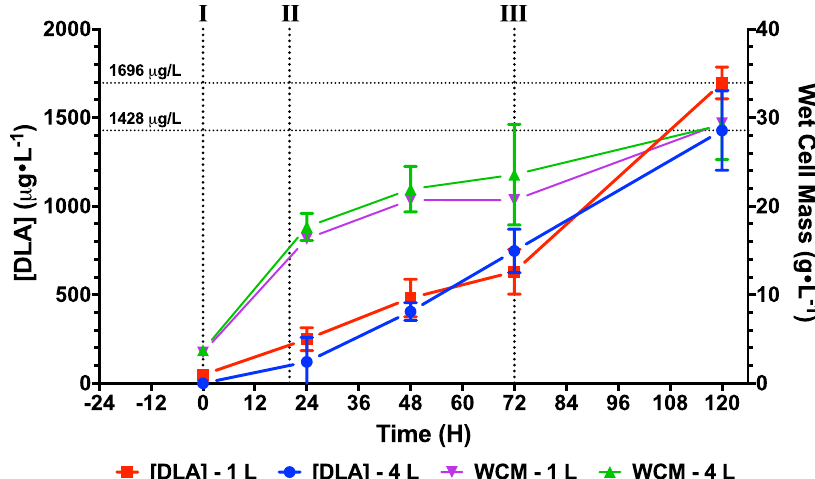
Fig. 6 Production of DLA from DLAM33B in 1 and 4 L scale fermentation. The fermentation process was modeled after the induction protocol used in shake fl ask experiments, with additional galactose and 10X SC-URA media supplemented at de fi ned feeding phases (I, II, III) in a fed-batch mode. 50 mM Ammonium-succinate was supplemented into the culture media from the onset to maintain a pH of 5.8. Both 1 and 4 L culture fermentations achieved